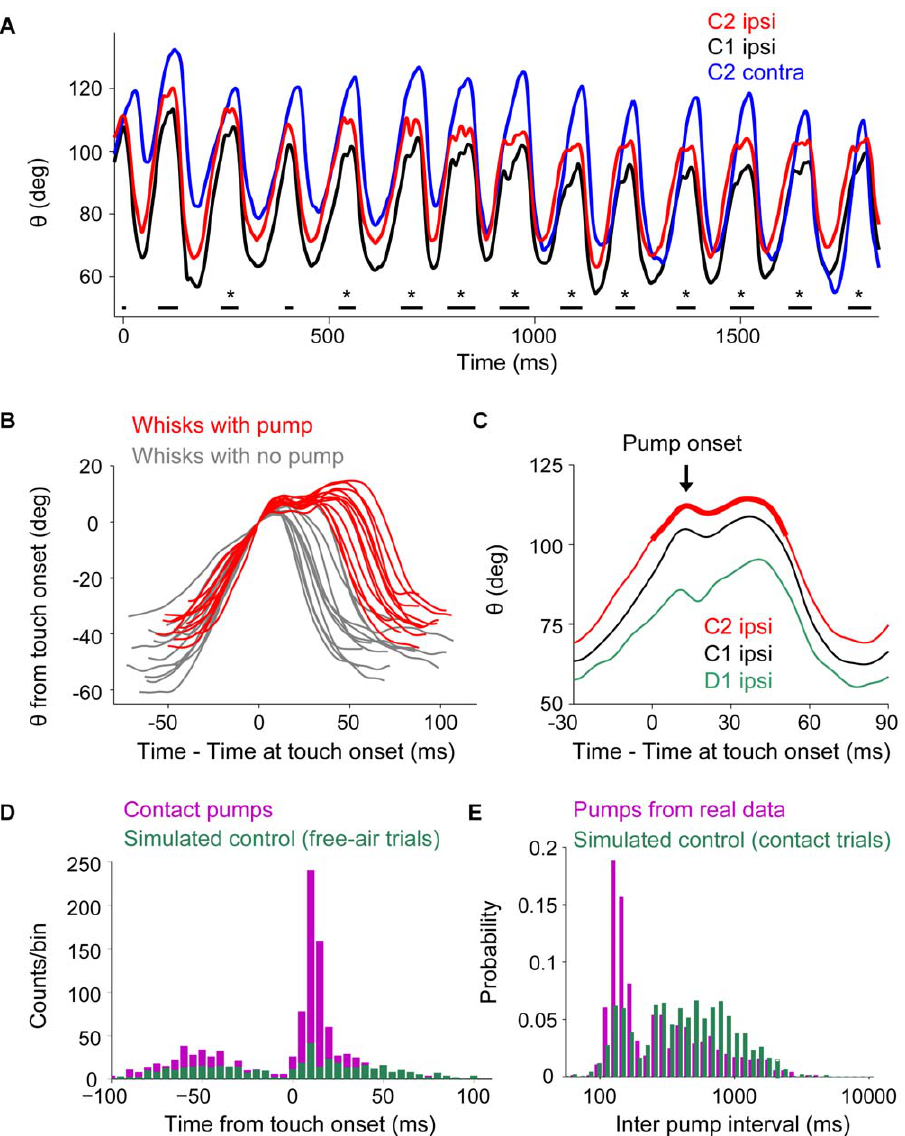
Figure 3. Fast, within-cycle touch-induced ipsilateral feedback. A. Angle trajectory from a contact trial, filtered at 80 Hz. Whisker C2 (red) touched the pole near the end of protraction. Touch events are indicated by black horizontal lines. TIPs (manually detected in this example) are indicated by asterisks. The first touch depicted was also the first touch in the trial. Data for ipsilateral C2 (red), ipsilateral C1 (black), and contralateral C2 (blue) whiskers. B. Angle trajectory of whisks with TIP (red) and without (grey), all taken from a single trial. Time and angle are presented with respect to their values at touch onset. C. Example of a touch-induced pump (TIP) that, after contact between whisker C2 and the pole, occurred simultaneously in the three untrimmed whiskers (C1, C2, D1). The C2 whisker was continuously in contact with the pole throughout the period marked touch (bold red line), so the whisker palpates against the pole without detaching from it. The TIP peak or onset (indicated by the arrow), the time of the first peak after touch, is followed by negative velocity. D. Time from touch onset (start of red bold line in C) to TIP onset (arrow in C) in contact trials (purple). The average latency of touch-induced pumps was 17.9 ms. The distribution of times between pseudo-touches (crossing of a threshold angle in free-air trials) and pump onset was normalized to have the same number of touches as in the contact data and is denoted in green. E. Inter-pump-interval (time between touch onsets in two neighboring whisks-with-TIP) with experimental (purple) and simulated (control; green) data. The control distribution is what is expected if the pumps had the same probability to occur, but were distributed randomly upon touch events. The peak around 140 ms is due to pumps that occurred in successive whisks (see Materials and Methods for detailed description on the controls used in Figs. 3D and 3E). trace is expected to be the protraction and the down trace the retraction phase. For double pump whisks, up and down traces are expected to represent also sub-components of individual whisks.